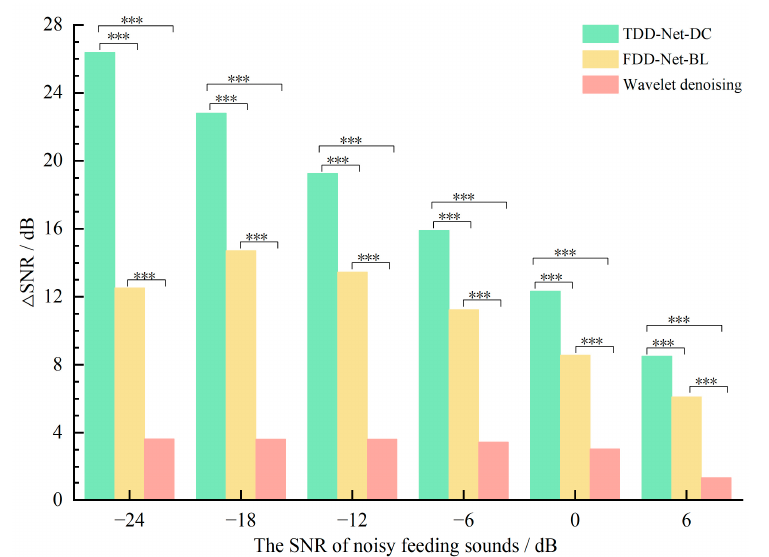
Figure 6. Comparison of the ∆ SNRs of different denoising methods at different SNRs, *** means highly significant ( p ≤ 0.001).